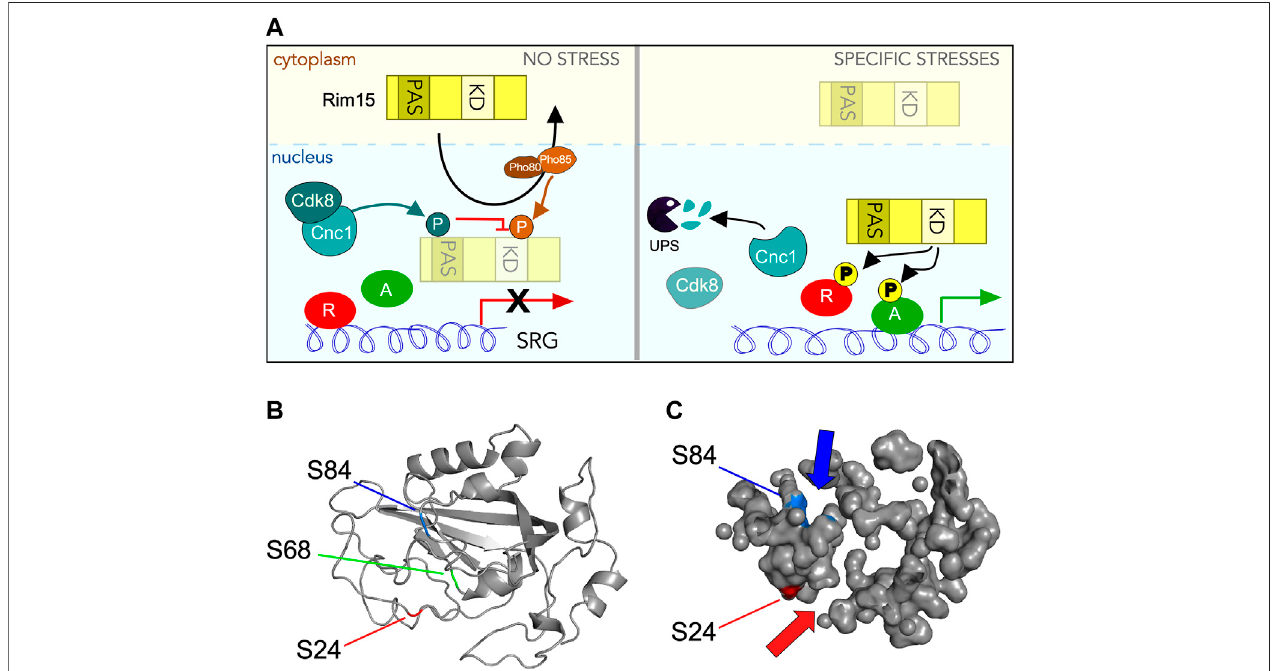
FIGURE10| ControlofRim15activitybyCdk8phosphorylation. (A) CartoonsummarizingtheroleofCdk8mediatedphosphorylationofRim15.Inunstressedcells (lefthandpanel)cyclinCactivatesCdk8whichthenphosphorylatesRim15whenitcirculatesthroughthenucleus.ThispreventsRim15dependentactivationofasubset of SRGs before it is Pho80/85 and Msn5 dependent nuclear export. Following a subset of stresses (right hand panel) cyclin C is destroyed by the UPS, thereby inactivating Cdk8. In these conditions, when Rim15 enters the nucleus it can act as a kinase, phosphorylating its downstream targets, resulting in the upregulation ofSRG ’ s. (B) Phyre2modeling(Kelleyetal.,2015;Reynoldsetal.,2018)oftheRim15PASdomainshowingtheconserved fi ve-strandedanti-parallel β -sheetstructurein the correct topological order with fl anking α -helices. Locations of serines 24 (red arrow), 68 (green line) and 84 (blue arrow) are indicated. (C) Solvent accessible surface mappingoftheRim15PASdomainusing Pymol(Schrödinger, 2020).LocationsofS24(red) andS84(blue)withrespect topocket formation.S24and S84aremodeled to be on different sides of the PAS domain but at the entrance to distinct pockets (indicated by